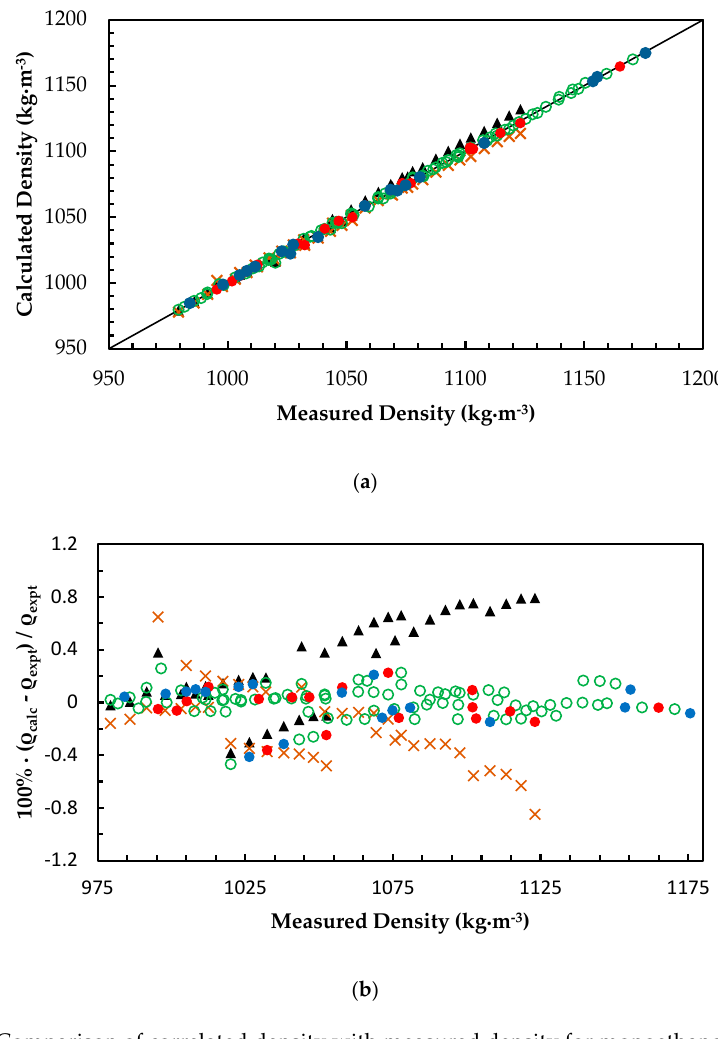
Figure 2. ( a ) Comparison of correlated density with measured density for monoethanol amine (MEA)